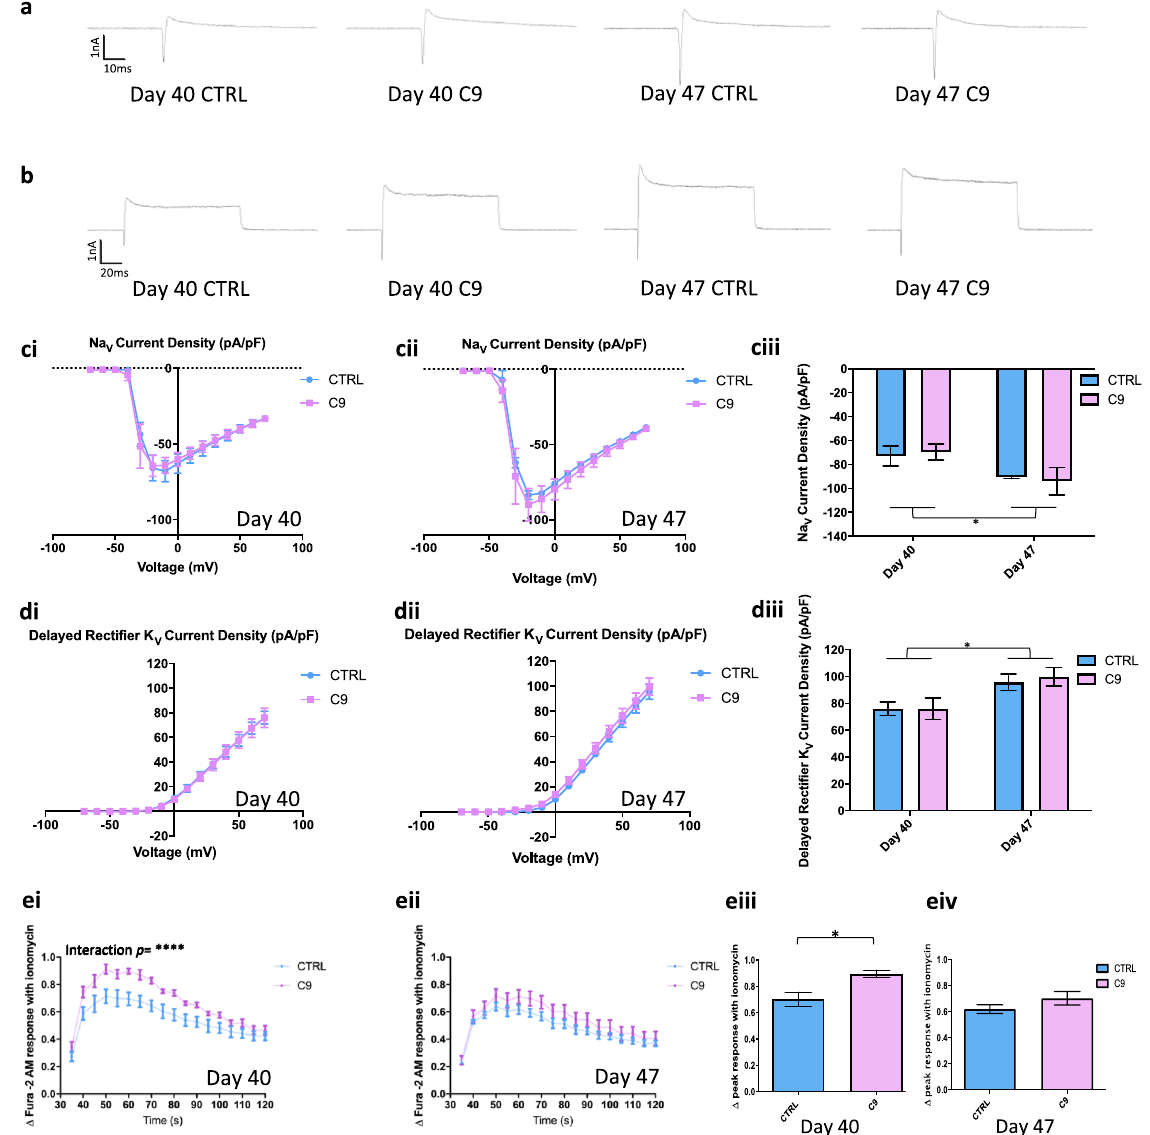
Figure 3. Transient calcium dyshomeostasis is evident in C9ORF72 MNs vs CTRL MNs. Example traces for Na V at − 20 mV ( a ) and K V at + 50 mV. ( b ) Current densities show no significant difference between the CTRL or C9 groups (Na V IV graph, ci ; K V IV graph, di ). The same measures also show no difference at day 47, (Na V IV graph, cii ; K V IV graph, dii ). However, a temporal comparison shows a significant increase of average peak current density of Na V current and K V current over time. Two-way RM ANOVA: Interaction Na + /K + p = ns, Time *Na + p = 0.0282, *K + p = 0.0145, Genotype Na + /K + p = ns with Sidak’s multiple comparisons Na + /K + p = ns, N = 3 lines, 1–2 differentiations. Investigation of calcium store release (ei, eii; mean ± SEM) evoked by ionomycin injection showed a significant increase in the delta Fura-2 AM fluorescence of C9 versus CTRL at Day 40 (eiii; Two-way RM ANOVA: Interaction **** p = < 0.0001, Time p = < 0.0001, Genotype p = ns) but not Day 47 (eiv; Interaction p = ns, Time p = < 0.0001, Genotype p = ns.) Unpaired T-Test p * < 0.05, N = 3 lines, 2–3